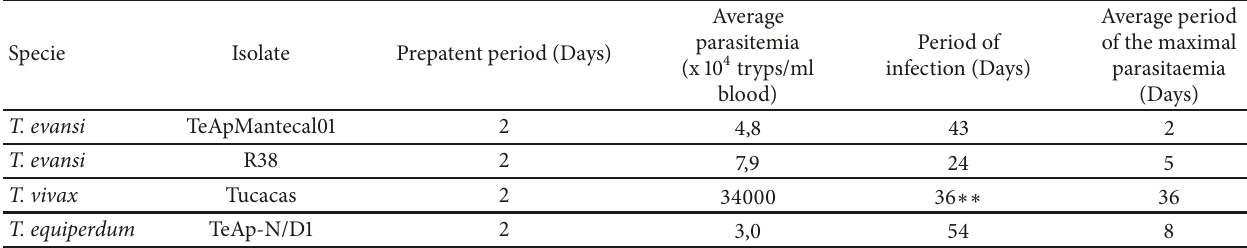
Table 2: Biological data of T. evansi, T. equiperdum , and T. vivax isolates during the experimental infection in sheep. ∗∗ trypanocidal treatment was applied to the